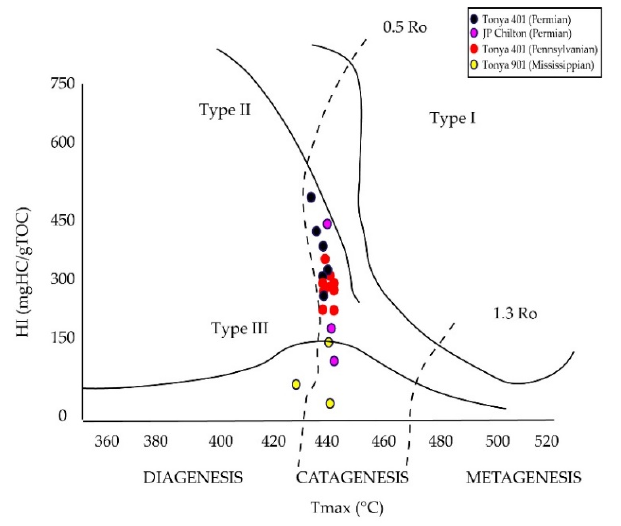
Figure 11. Organic matter types with arrows indicating the progression of maturation modified from Taylor et al., 1998 [120].